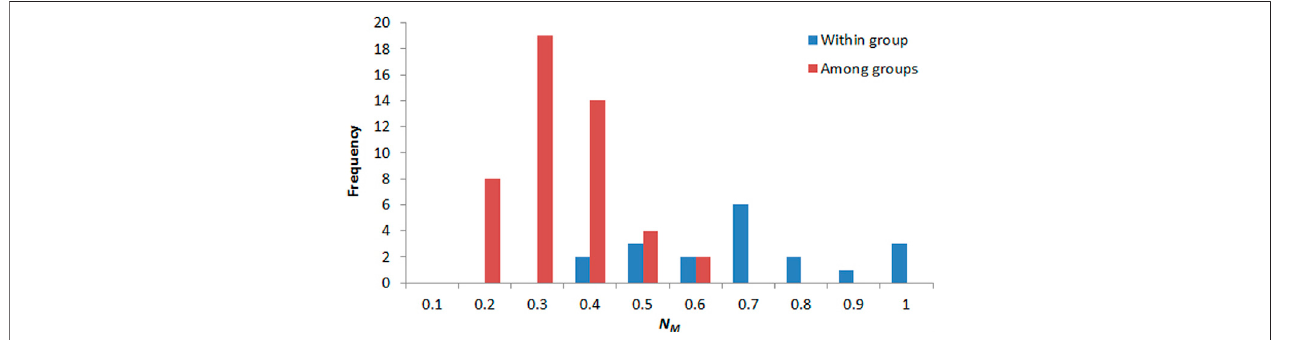
Frontiers in Genetics |